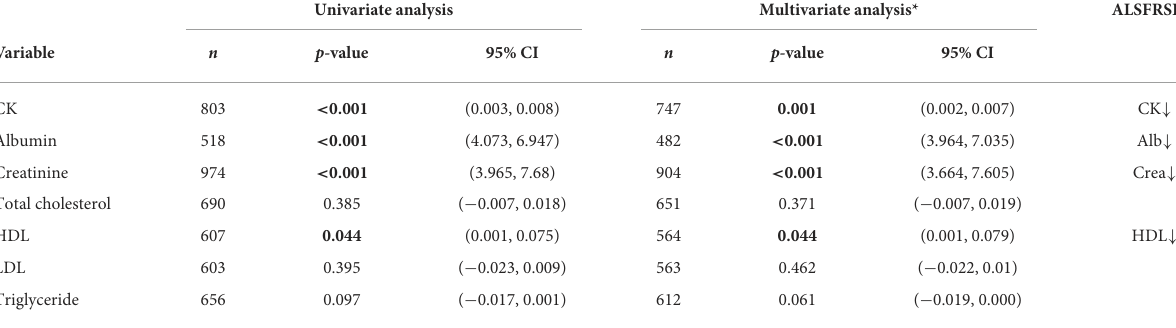
TABLE 5 Linear regression models for ALSFRSR at study entry and blood parameters.